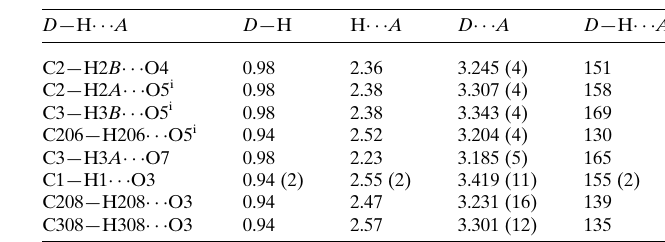
Table 2 Hydrogen-bond geometry (A˚ , (cid:3) ) for 1b .